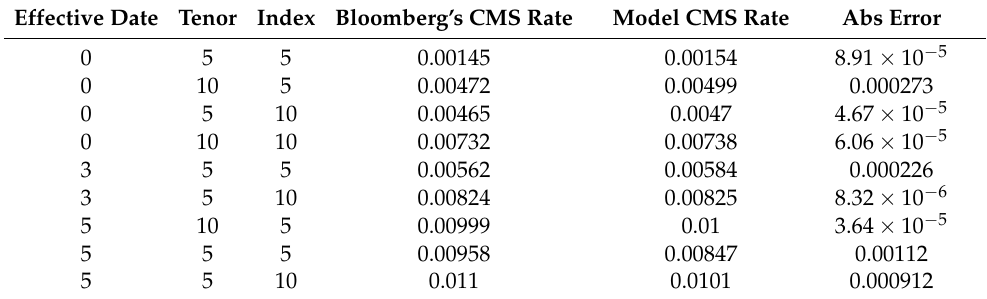
Table 4. CMS rates computed with a calibration using I 2 and fmincon to the column with tenor 7 of the payer swaption surface with maturities ranging from 5 to